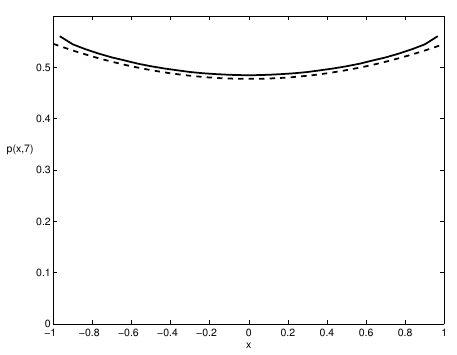
Figure 1. Numerical solution of the integral formulation for the McFadden interval distribution at quasi-equilibrium (solid line), and the exact solution at equilibrium (dashed